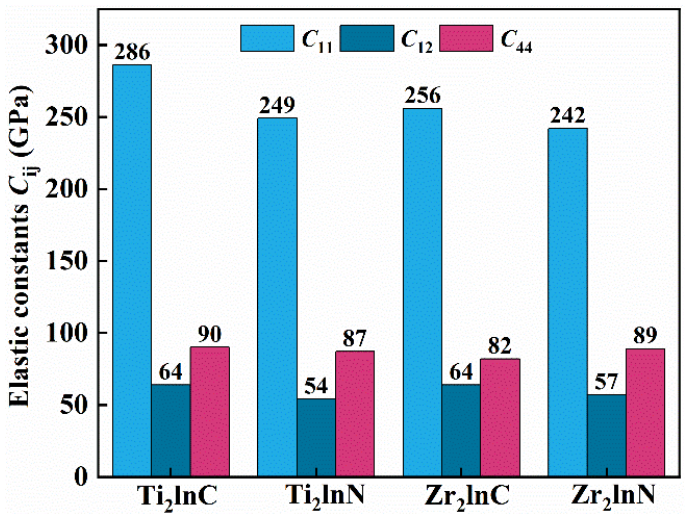
Figure 3. The elastic constants C ij (in Gpa) of M 2 InX (M = Ti, Zr and X = C, N) MAX phases.